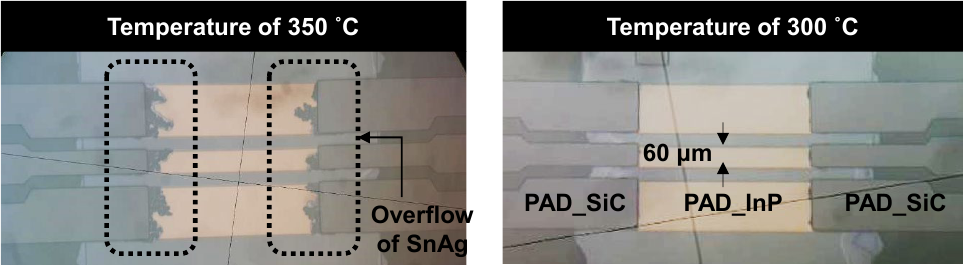
Figure 7. Microscope images of a flip-chip-bonded InP-to-SiC sample with different bonding temperatures of 350 and 300°.